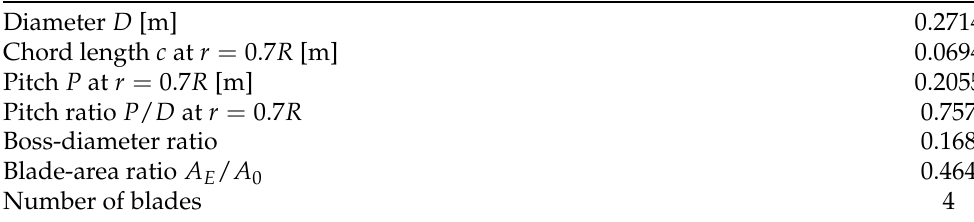
Table 2. Overview of propeller